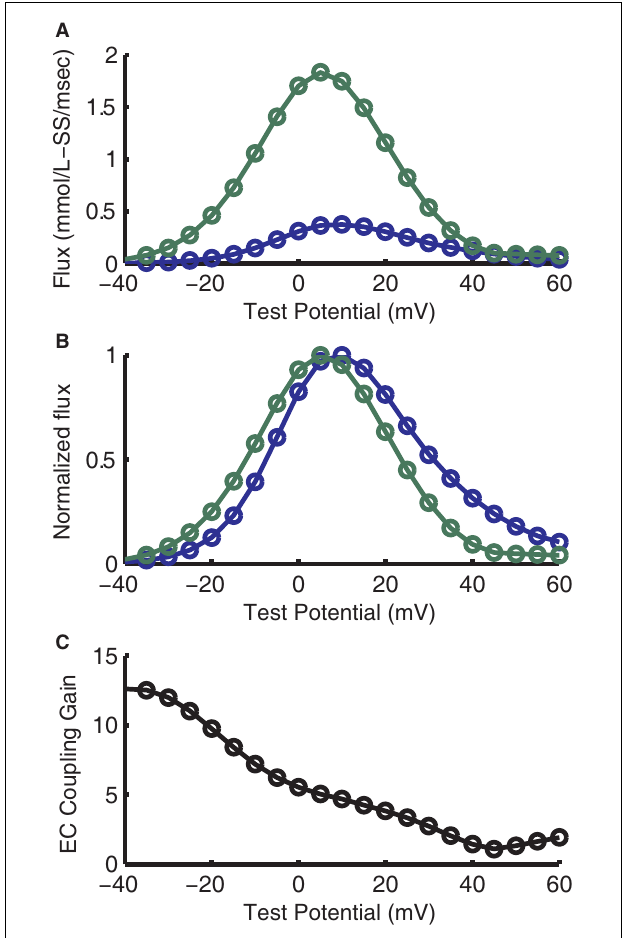
FIGURE 8 |Voltage-dependence of flux through LCCs and RyRs and ECC gain. (A) Voltage-dependence of maximal Ca 2 + flux through LCCs (blue) and RyRs (green). (B) Normalized fluxes from (A) . (C) ECC gain, as formulated by the ratio of maximal LCC flux to maximal RyR flux.